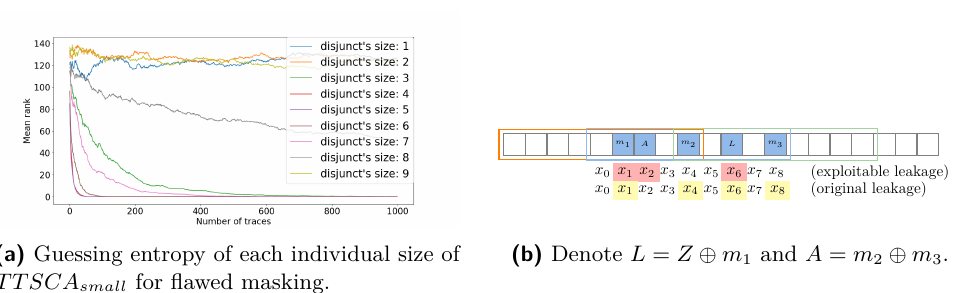
TTSCA small for flawed masking. Figure 7: Guessing entropy when using step 1 and a visualization of the simulated data with flawed masking.